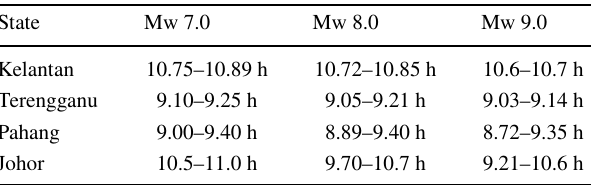
Table 2 Arrival time of tsunami waves from Manila Trench earth- quake source State